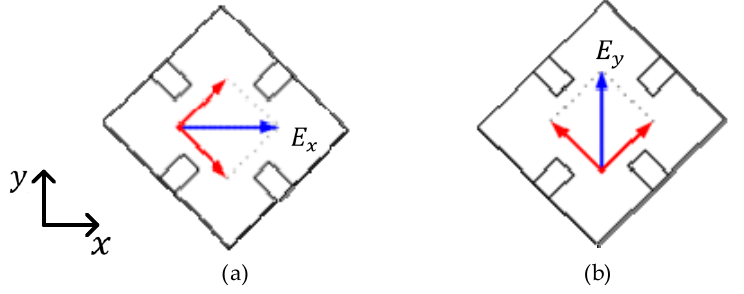
Figure A1 . Polarizer input. ( a ) Horizontal ( 𝐸 (cid:3051) ) and ( b ) vertical ( 𝐸 (cid:3052) ) electric field (blue). With Figure A1. Polarizer input. ( a ) Horizontal ( E x ) and ( b ) vertical ( E y ) electric field (blue). With orthogonal TE 10 and TE 01 components (red). orthogonal TE 10 and TE 01 components